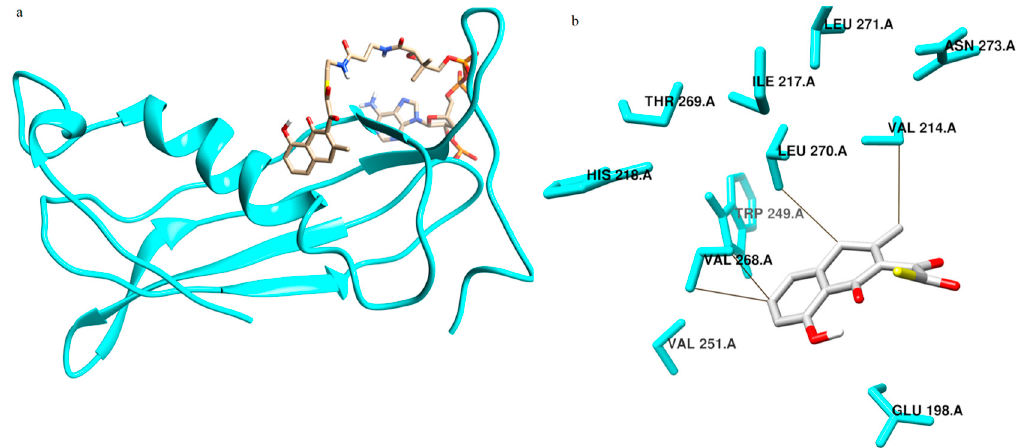
Figure 4. Structure of thioesterase with IS 1 in the active site. ( a ) Thioesterase in the ribbon model with IS 1 in the stick model. ( b ) Residues making contacts with IS 1 in thioesterase.